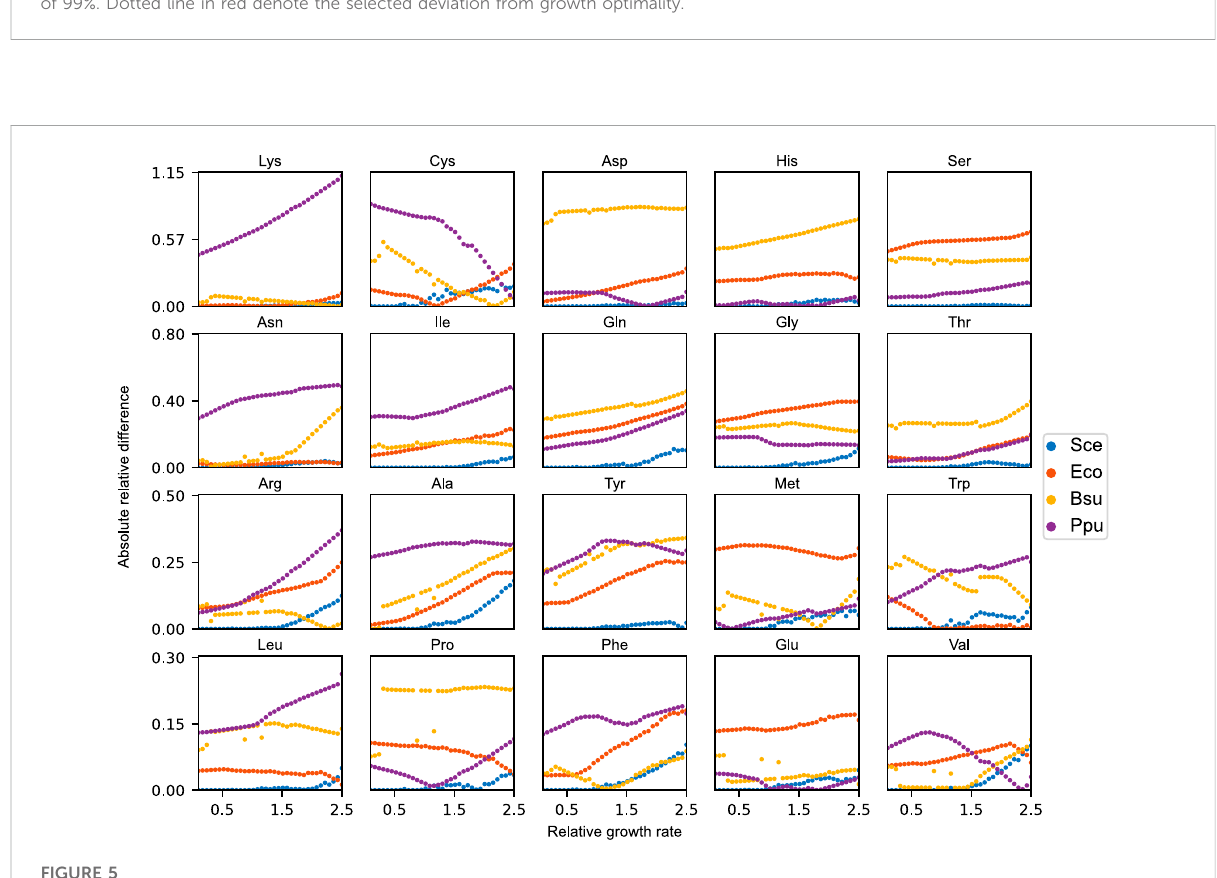
FIGURE 5 Absolute relative difference of each amino acid between the species-speci fi c amino acid distributions and the simulated amino acid pro fi les of the acidFBA-GEM at increasing relative growth rates. The simulated pro fi les were obtained by minimizing the Euclidean distance to the